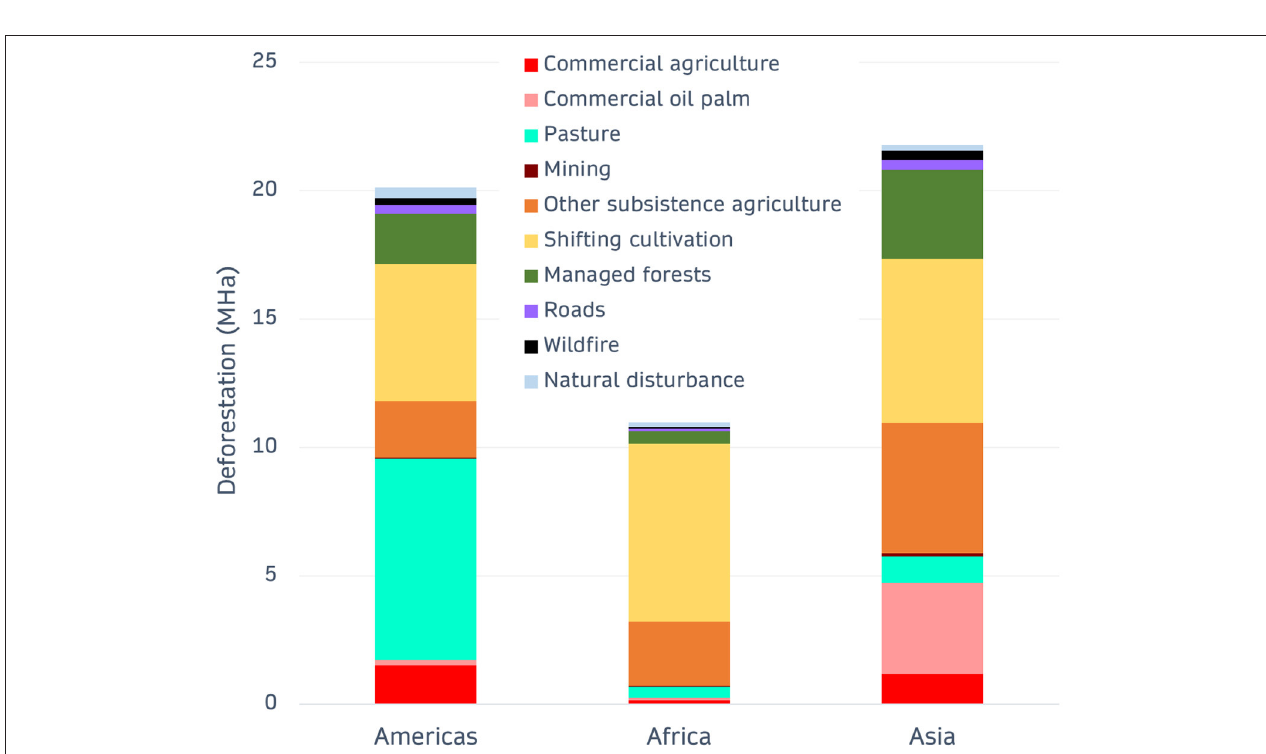
FIGURE 5 | The amount of deforestation (in MHa) in protected areas by driver in the Americas, Africa, and Asia in the area 30 ◦ latitude north and south of the equator.